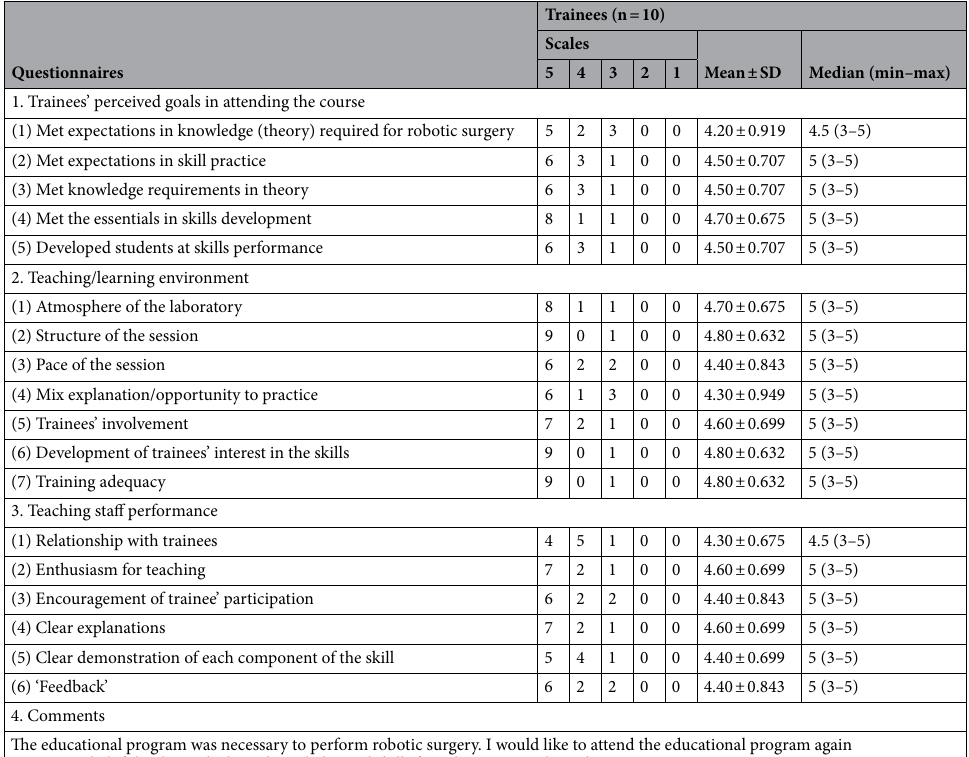
Table 3. Modified questionnaires for the trainees of cadaveric skill lab for robotic-assisted nipple-sparing mastectomy (grading scale: 1—insufficient/inadequate; 2—reasonable/adequate; 3—sufficient; 4—good; 5— very